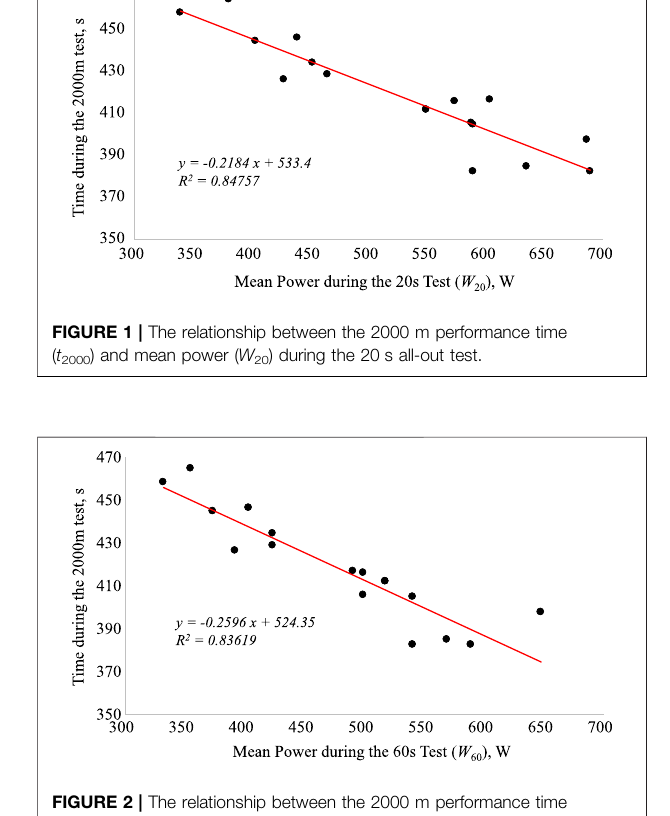
TABLE 1 | Correlation between 2000 m rowing ergometer performance time (t 2000 ) and anaerobic characteristics of the 17 participants.